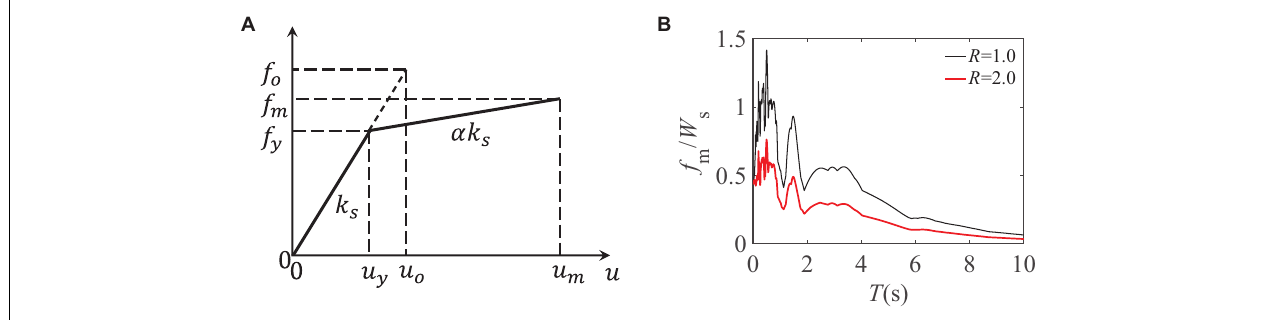
FIGURE 1 | (A) Bilinear force-deformation relationship of inelastic SDOF system and corresponding elastic system (adopted from Chopra and Chintanapakdee, 2004); (B) elastic and inelastic normalized force demand spectra for a representative ground motion.